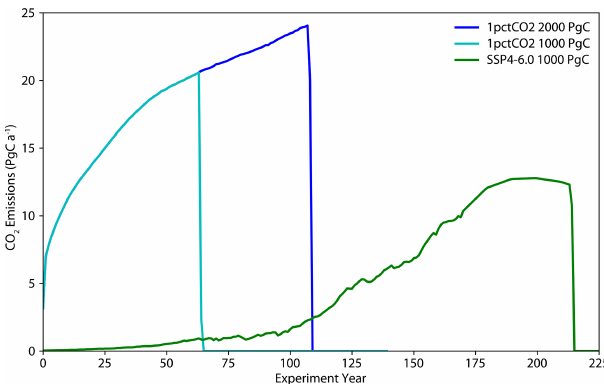
Figure 2. Emissions trajectories for the three experiment sets con- ducted for this